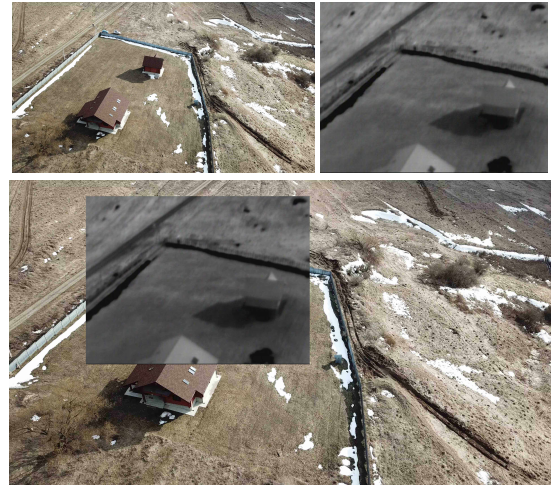
Figure 7. Image orientation and synchronization Non-linear minimization of the observation (re-projection) errors by bundle adjustment (Knyaz, 2010) is used to determine cam- era exterior orientation for images not used in 3D reconstruction procedure. Redundant number of reference points is used in bun- dle adjustment procedure of minimizing the squared re-projection error for the 2D image coordinates of reference points x ij in an image j as a function of the unknown image exterior orientation parameters ( R, X ) and known reference 3D point coordinates p